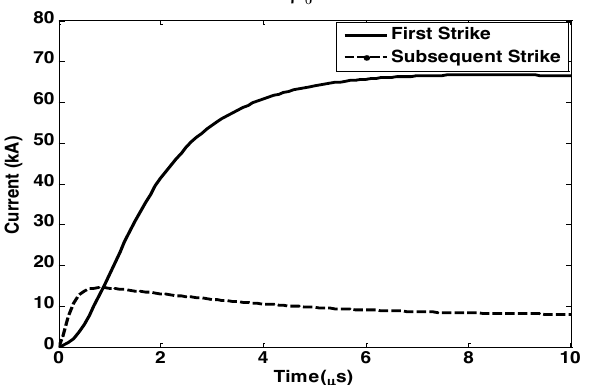
Figure 5: Frequency variation of electrical parameters of soil for low-frequency resistivity .